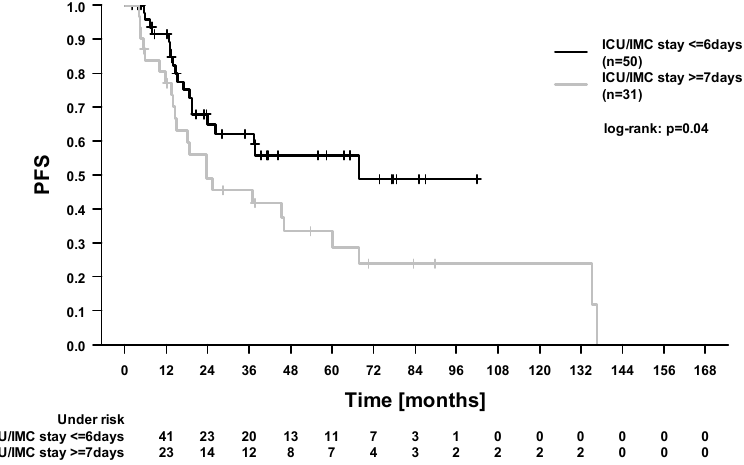
Figure 4. Progression-free survival (PFS). Comparison of survival according to the stay on intensive care/intermediate care unit (ICU/IMC).